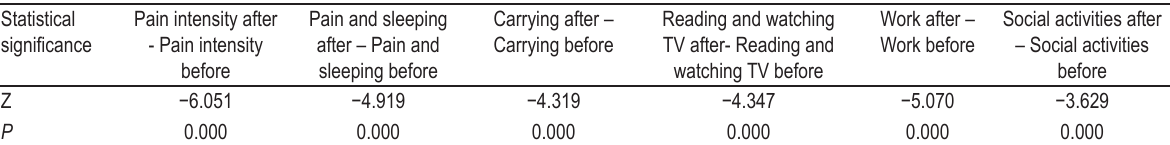
TABLE 12. Statistical significance of the measured